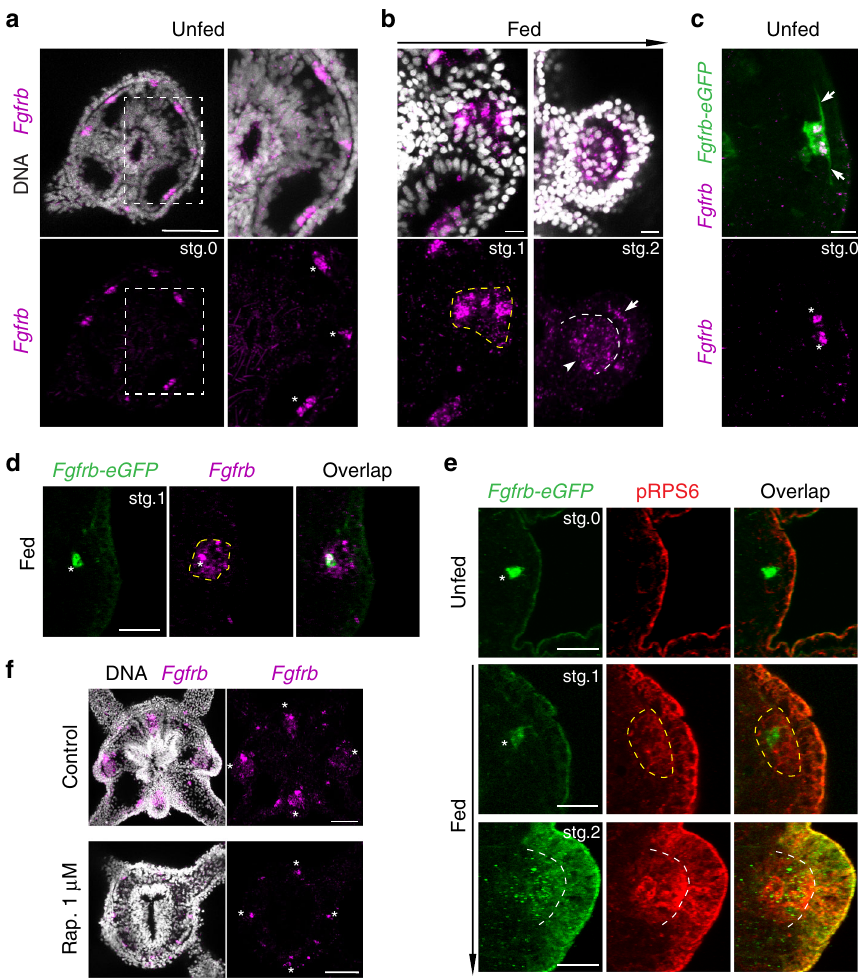
Fig. 6 Fgfrb- positive ring muscles pre-mark the sites of tentacle primordia. a , b Fluorescent in situ hybridization of Fgfrb (unfed polyps n = 8, fed polyps n = 14, two independent experiments). a Confocal z -projections of the oral pole of unfed polyp showing Fgfrb expression (purple) and nuclei (white). Inset box is a zoom in of s3 segment. b Confocal z -projections of developing buds at sequential stages. White arrow and arrowhead indicate outer- and inner- body layer, respectively. c , d Confocal z -projections of the Fgfrb-eGFP transgenic line stained with α -eGFP (green) and labeled for Fgfrb mRNA (purple) (unfed polyps n = 6, fed polyps n = 5, two independent experiments). White arrows show the elongated basal parts of ring muscles. White arrowheads indicate nuclear localization of Fgfrb mRNA in the eGFP-positive cells. Yellow dashed line delineates the expression domain of Fgfrb after feeding. e Confocal z -projections of unfed and fed Fgfrb-eGFP polyps stained with α -eGFP (green) and pRPS6 antibody (red) in three independent experiments. Yellow dashed line delineates the domain of pRPS6-positive cells. White dashed line separates the two body layers. f Confocal projection of the oral pole of fed controls and fed rapamycin-treated polyps stained with Hoechst (white) and labeled for Fgfrb mRNA (purple). Note the expansion of Fgfrb expression in tentacle primordia in controls ( n = 8 polyps), while there is no change in Fgfrb expression in rapamycin-treated polyps ( n = 11 polyps) in two independent experiments. White asterisks indicate Fgfrb -expressing cells in the oral segments. Scale bars are 100 μ m. Scale bars are: 50 μ m in a and f , 10 μ m in b and c , and 20 μ m in d and e